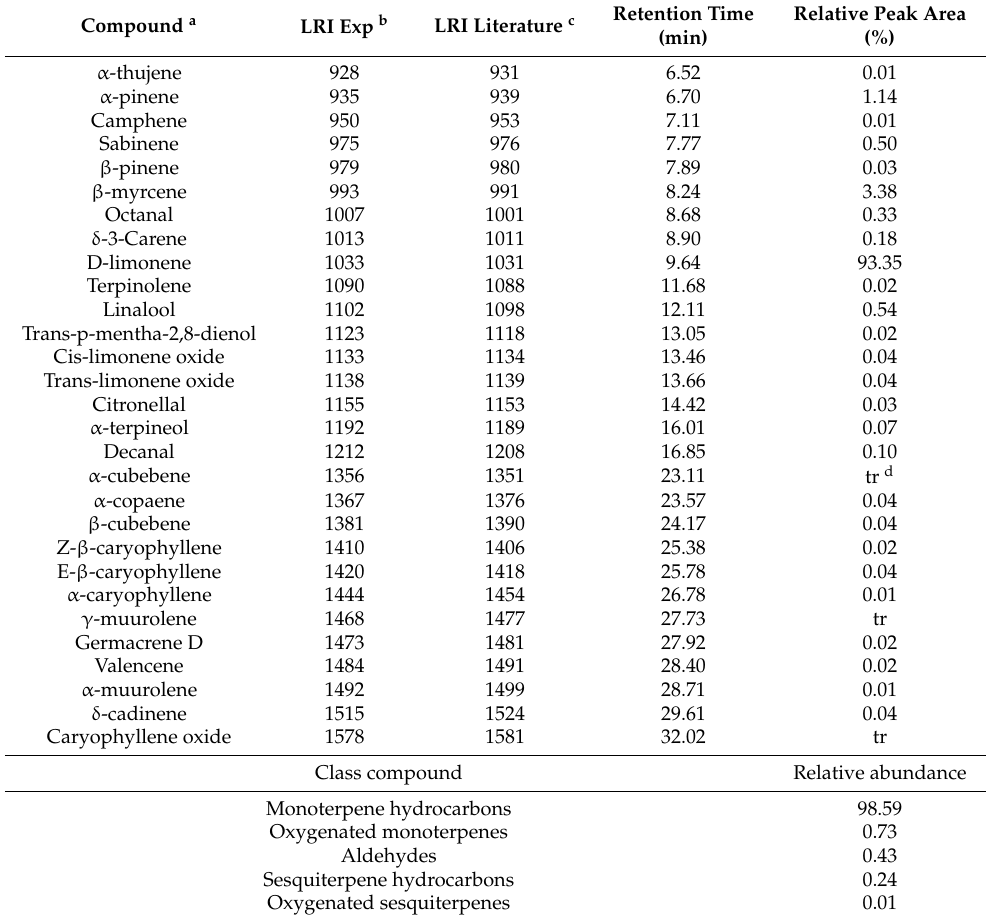
Table 1. Chemical composition of the essential oil extracted from sweet orange fruit (cv. Tarocco